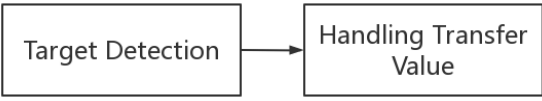
Figure 2. Identify readings based on CSL